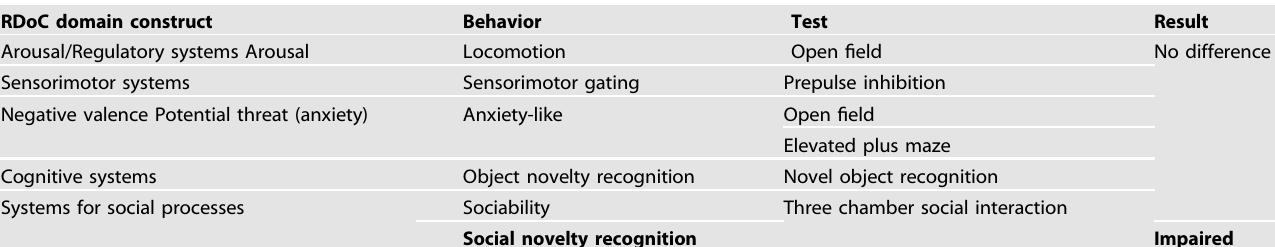
Table 2. Selective behavioral de fi cits of Notch1 + / − males only in a social novelty recognition behavior, but not in other behavioral paradigms.